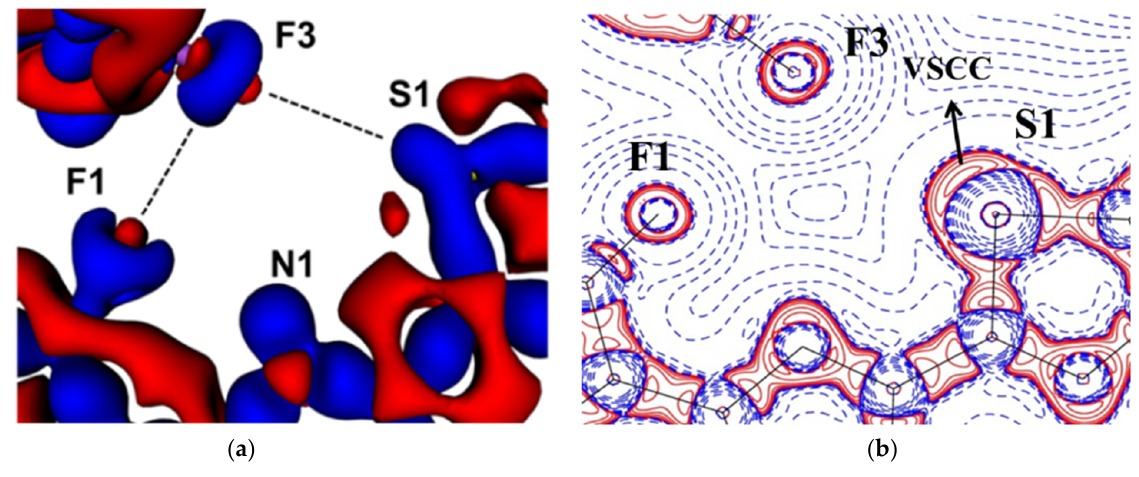
Figure 4. ( a ) Deformation density ( ∆ ρ (r)) ( b ) Laplacian ( ∇ 2 ρ (r)) maps in the F ··· F and S ··· F interaction region. ∆ ρ (r) isosurfaces are drawn at ± 0.05 eÅ − 3 . ∇ 2 ρ (r) (eÅ − 5 ) drawn in logarithmic contours. (Figures adopted from [28]). Table 1. The topological properties of the ED determined from the experimental multipolar model for Cl ··· Cl interactions. Theoretical values from the CRYSTAL calculations are given in italics. R ij =